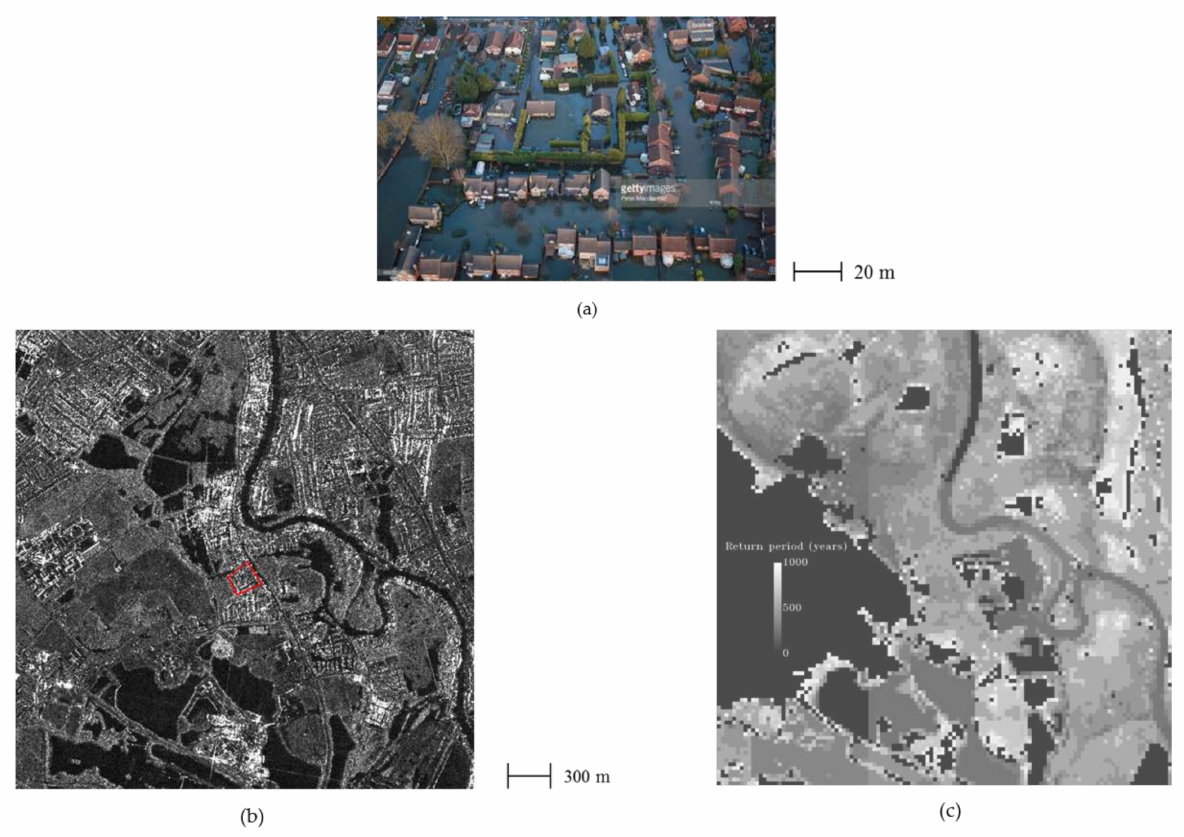
Figure 6. ( a ) Aerial photo of flooding in Blackett Close, Staines (51.4 ◦ N, 0.5 ◦ W; about 150 × 150 m) (© Getty Images 2014) (after [42]), ( b ) CSK subimage (3 × 3 km) of Thames flood in Staines, West London on 13 February 2014 (pixel intensities are DN backscatter values, and dark areas are water;red outline shows the arecovered by aerial photo), and ( c ) flood return-period map (black areas masked